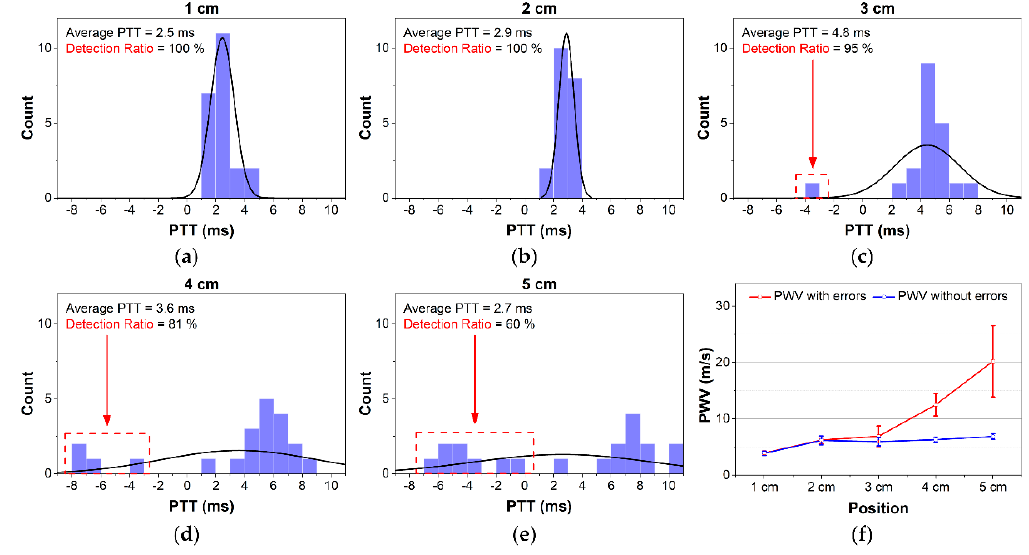
Figure 11. ( a – e ) Distribution of measured PTT at various distances over 20 s; ( f ) PWV with and without PTT errors at various distances.